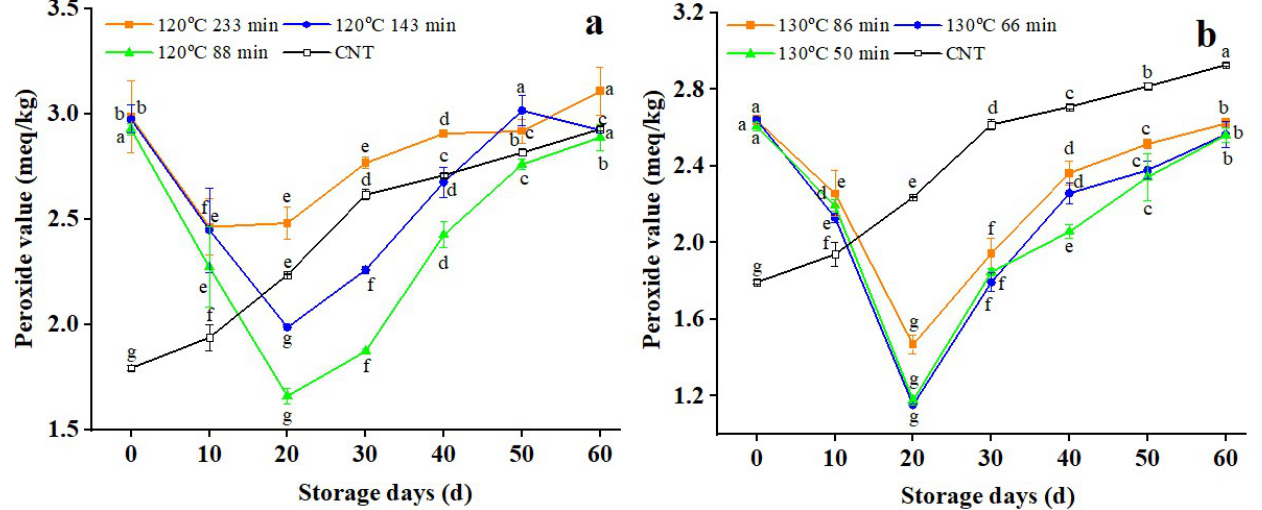
Figure 4. Changes in the peroxide values of rice bran after dry-heated treatment. Note: The lowercase letters refer to the significant difference of the same sample for different storage periods at the same temperature and treatment conditions at p < 0.05. CNT: Control.